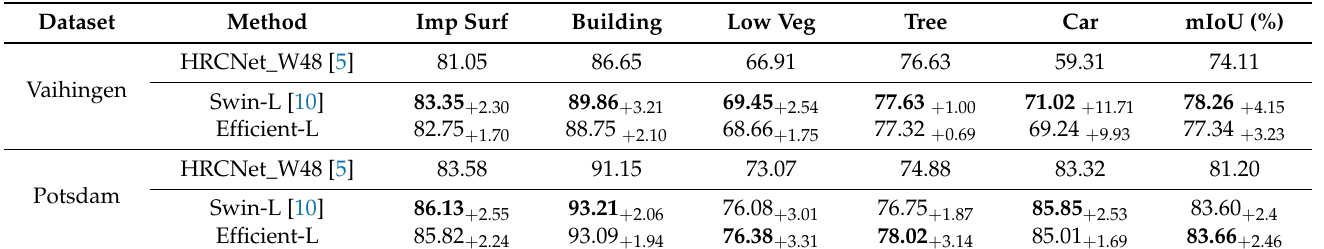
Table 13. IoU scores of each category on the Vaihingen and Potsdam datasets.